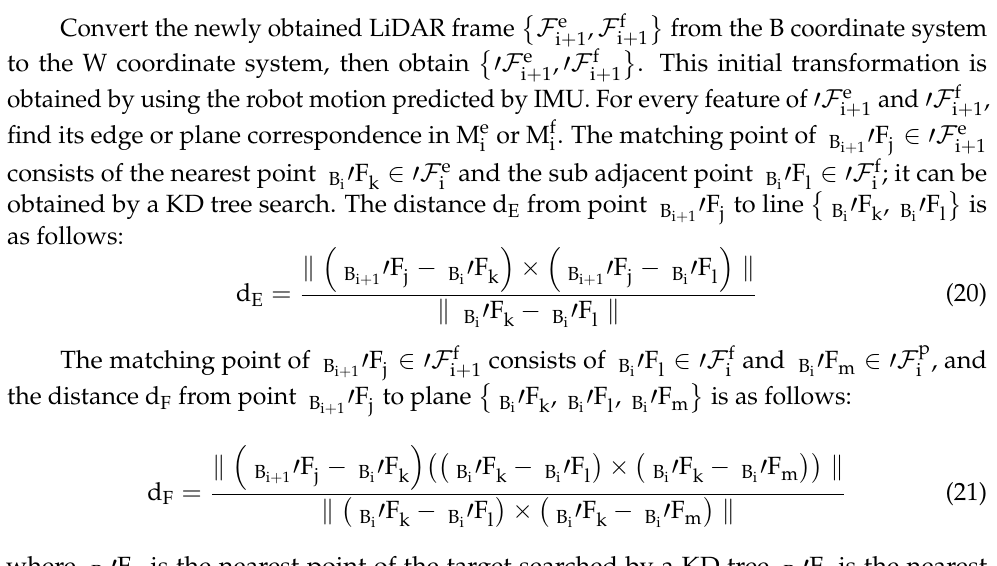
Figure 3. Fusion results of the visual and laser features.